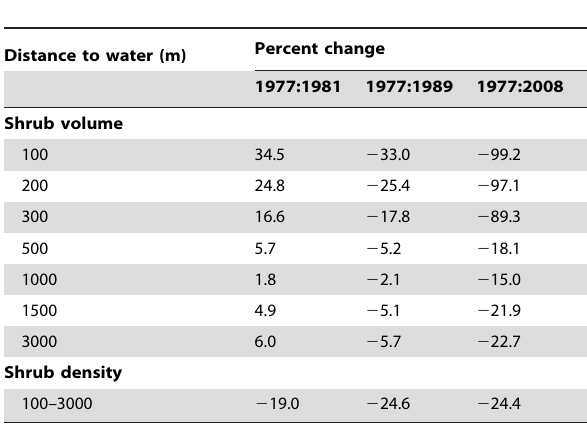
Table 2. Percentage change in canopy shrub volume and shrub density over the experimental period as predicted by mixed-effects logistic growth models (see Fig. 5; Table